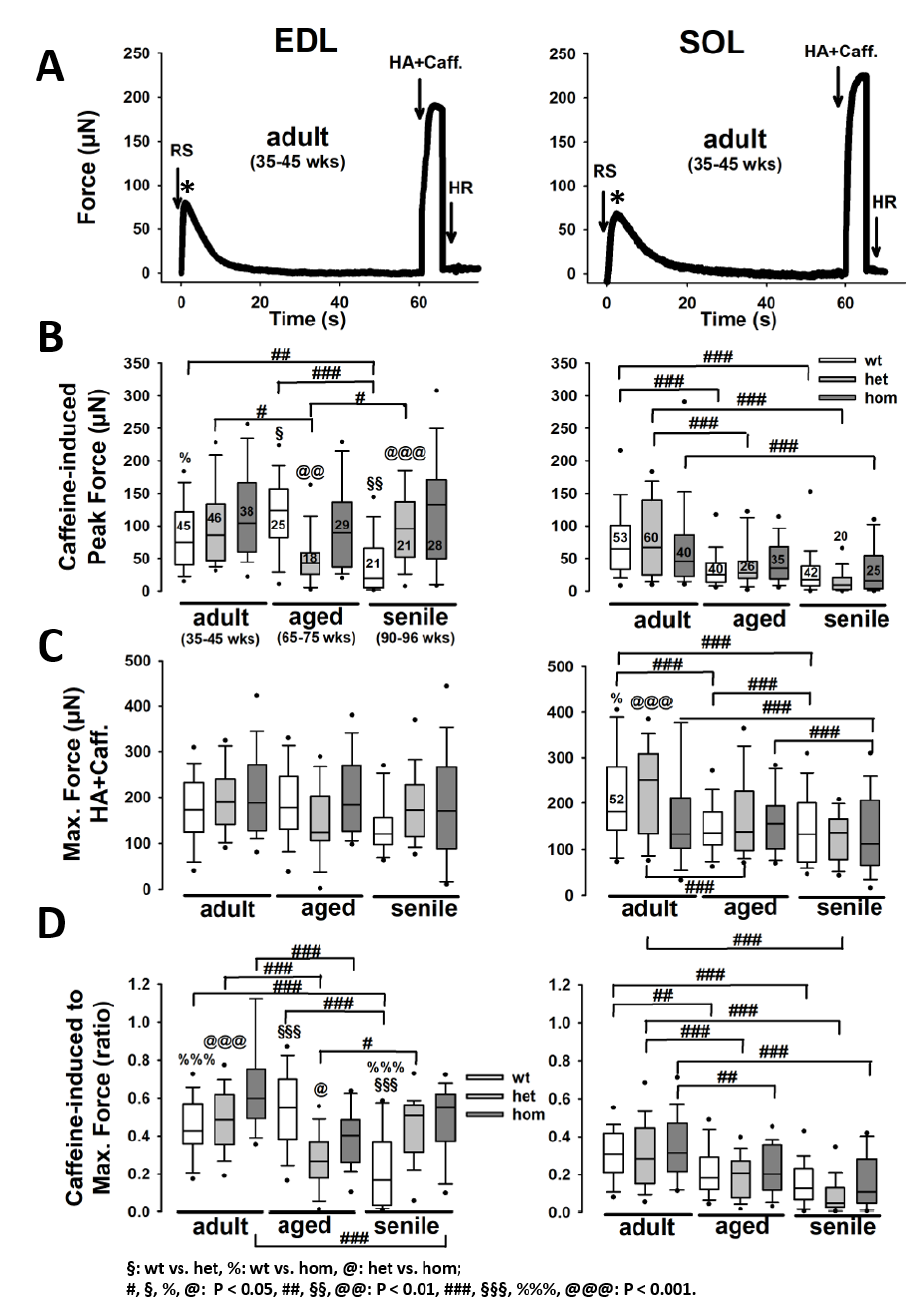
Figure 1. Caffeine-induced force and maximum Ca 2 + -saturated force in single Musculus extensor digitorum longus (EDL) and Musculus soleus (SOL) fibers from adult, aged, and senile R349P desmin mice. ( A ) Representative force recordings in a single EDL (left) and SOL (right) fiber. Group analysis of peak force amplitude during caffeine release (RS) ( B ), steady-state maximum force (HA) ( C ), and respective RS:HA force ratios ( D ) indicates an overall decrease in SR Ca 2 + release force during aging in EDL and SOL, regardless of genotype. Within age groups, RS peak force was significantly larger in hom EDL fibers for the adult and senile groups, while they were similar in SOL. In EDL, there was no difference in maximum attainable force among genotypes regardless of age. Thus, RS:HA force ratios in EDL reflect the pattern differences of RS peaks, while in SOL fibers, relative force during SR Ca 2 + release over maximum Ca 2 + -saturated forces were similar among genotypes and showed a significant decrease with age. Significance tested with two-way ANOVA followed by post hoc analysis (Bonferroni). Numbers in box plots: number of single fibers analyzed; also valid for panels (C,D). *: indicates caffeine-induced force